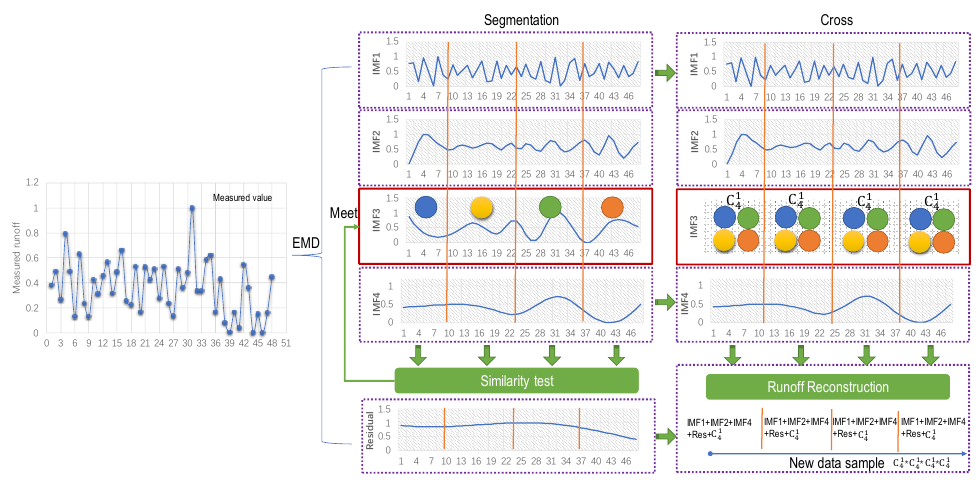
Figure 3. The process of component reconstruction.